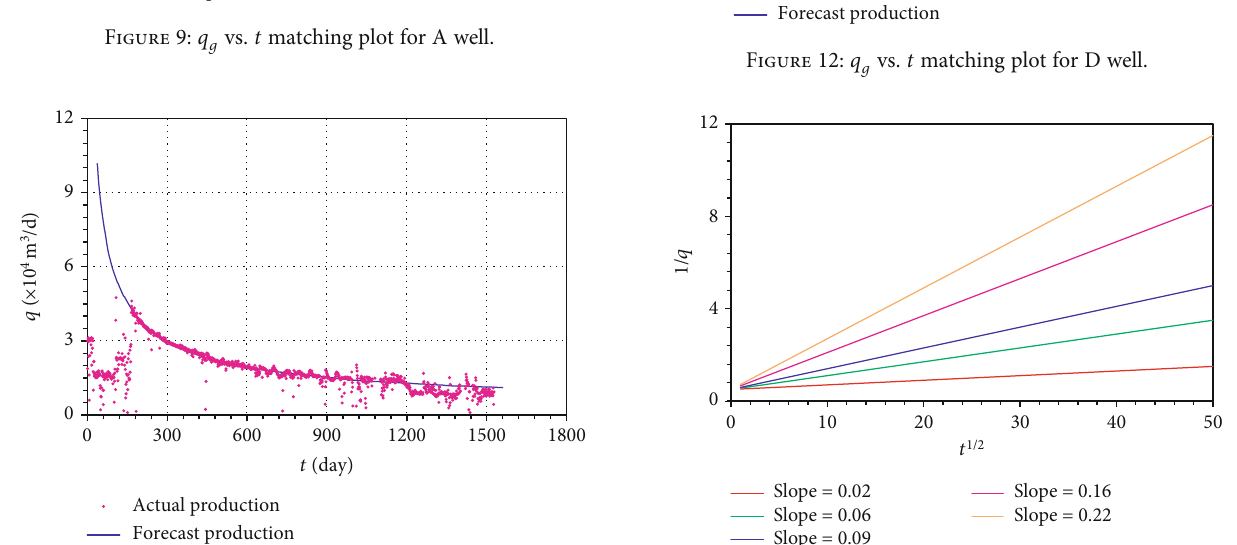
Figure 10: q vs. t matching plot for B well. g